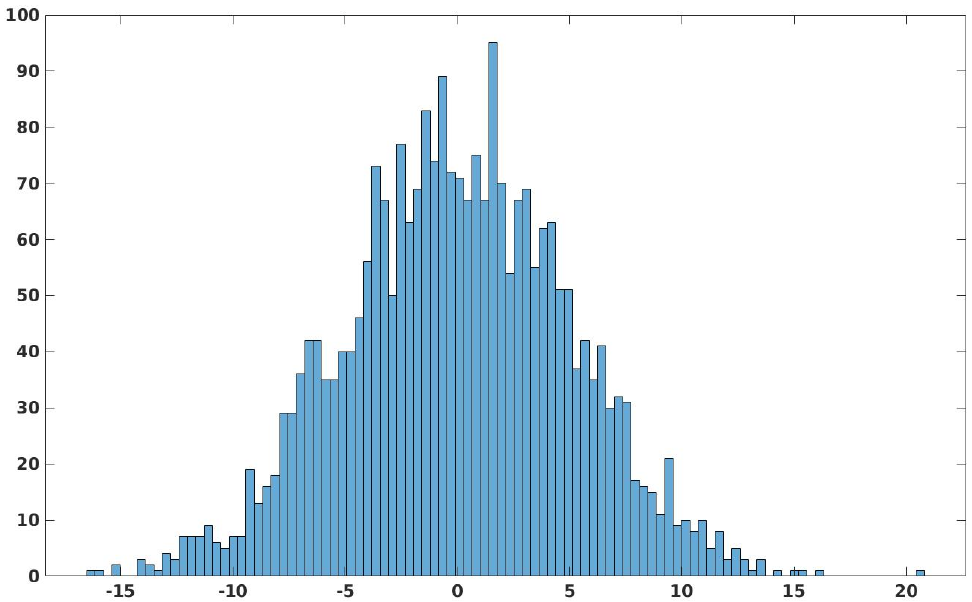
Figure 4. The histogram of DCT coefficients of the forged region in the image, which behaves as singly compressed.